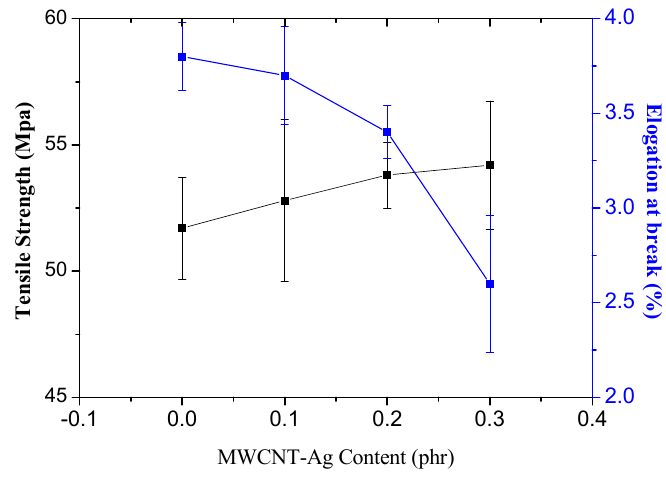
Figure 3. Tensile properties of the PLA and PLA/MWCNT-Ag